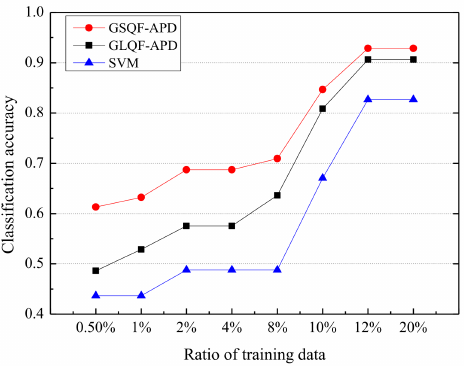
Figure 6. Classification accuracy of House 2 using GSQF-APD, GLQF-APD, and SVM algorithms. With respect to the training complexity, we adopted the average training time as a metric. When two days of data are used, comprising over N = 2800 samples, the average training time for REDD is about 7.64 s. It is faster than the sparse coding based method which disaggregates the same amount of data in about 25 s, as reported in Ref.